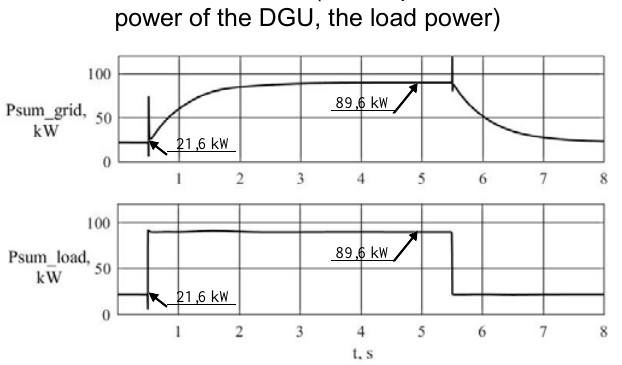
Figure 9. Calculation: transient process with ESS in the dI/dt Limitation Mode (from top to bottom - the power of the DGU, the load power)